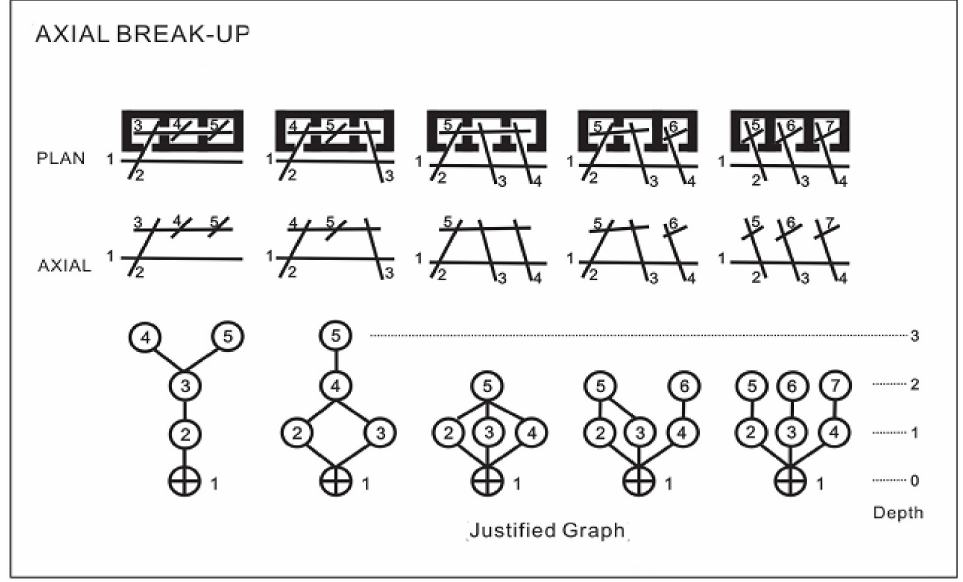
Figure 1. Dynamic space syntax graph